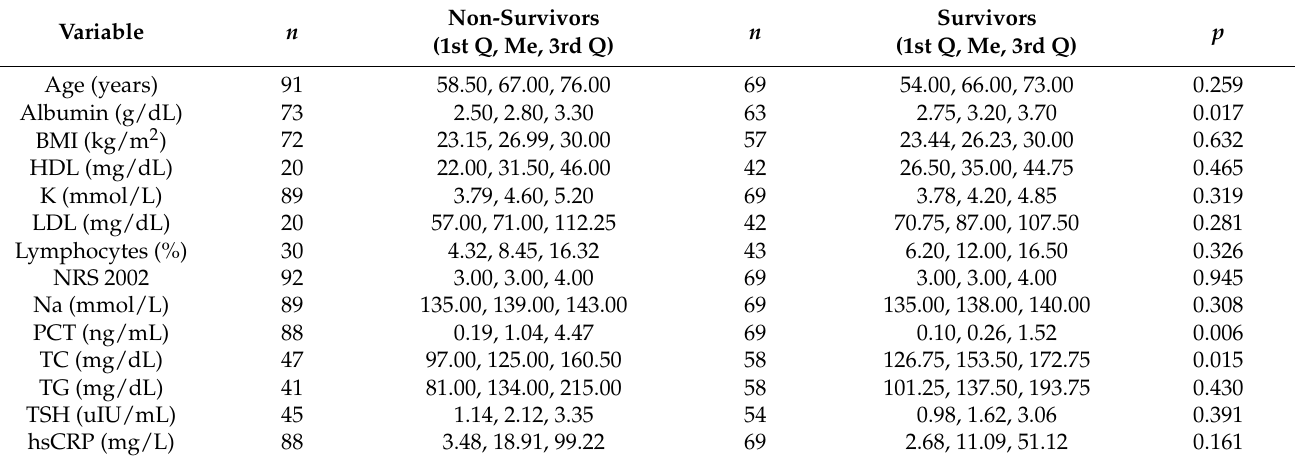
Table 4. Differences between non-survivors and survivors (continuous variables).